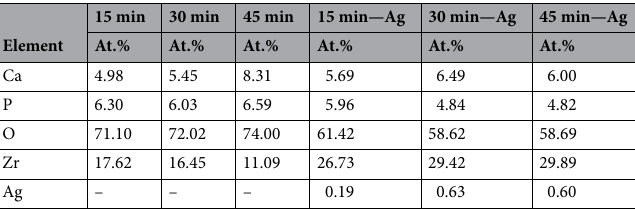
Table 1. EDX area results of the MAO and AgNPs-doped MAO surfaces.